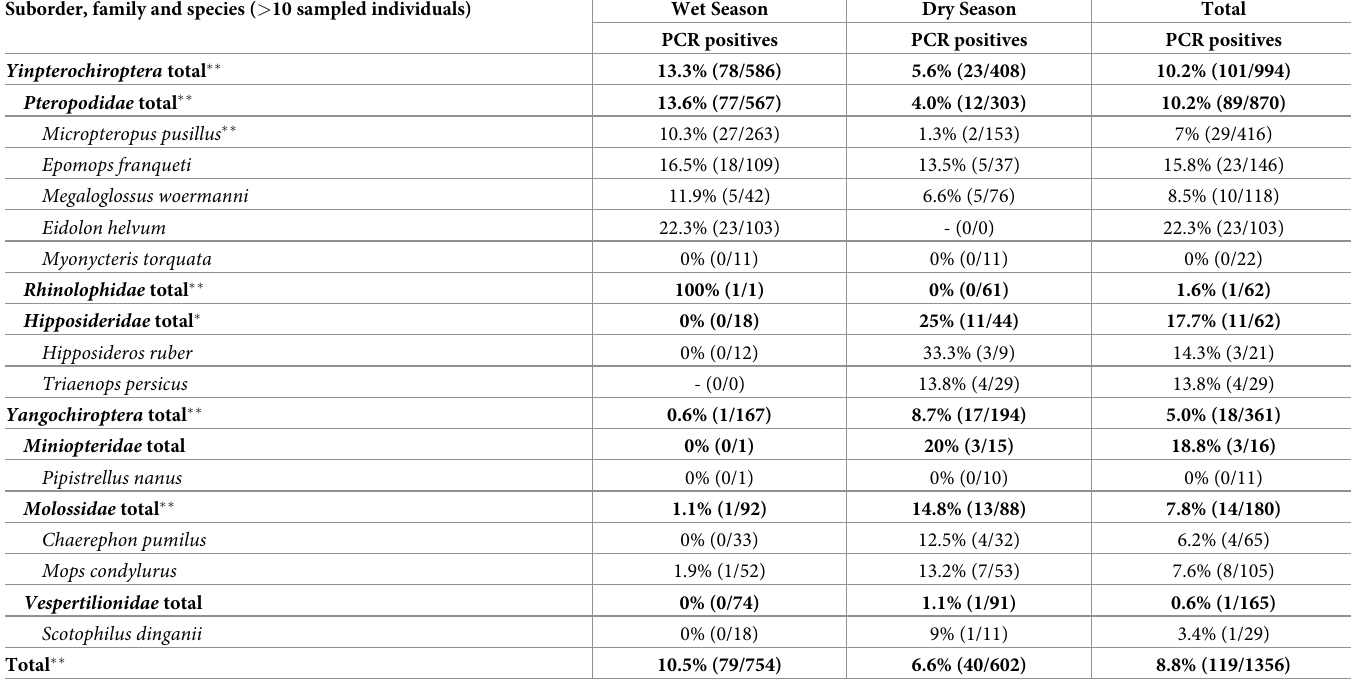
Table 1. PCR results by species and season